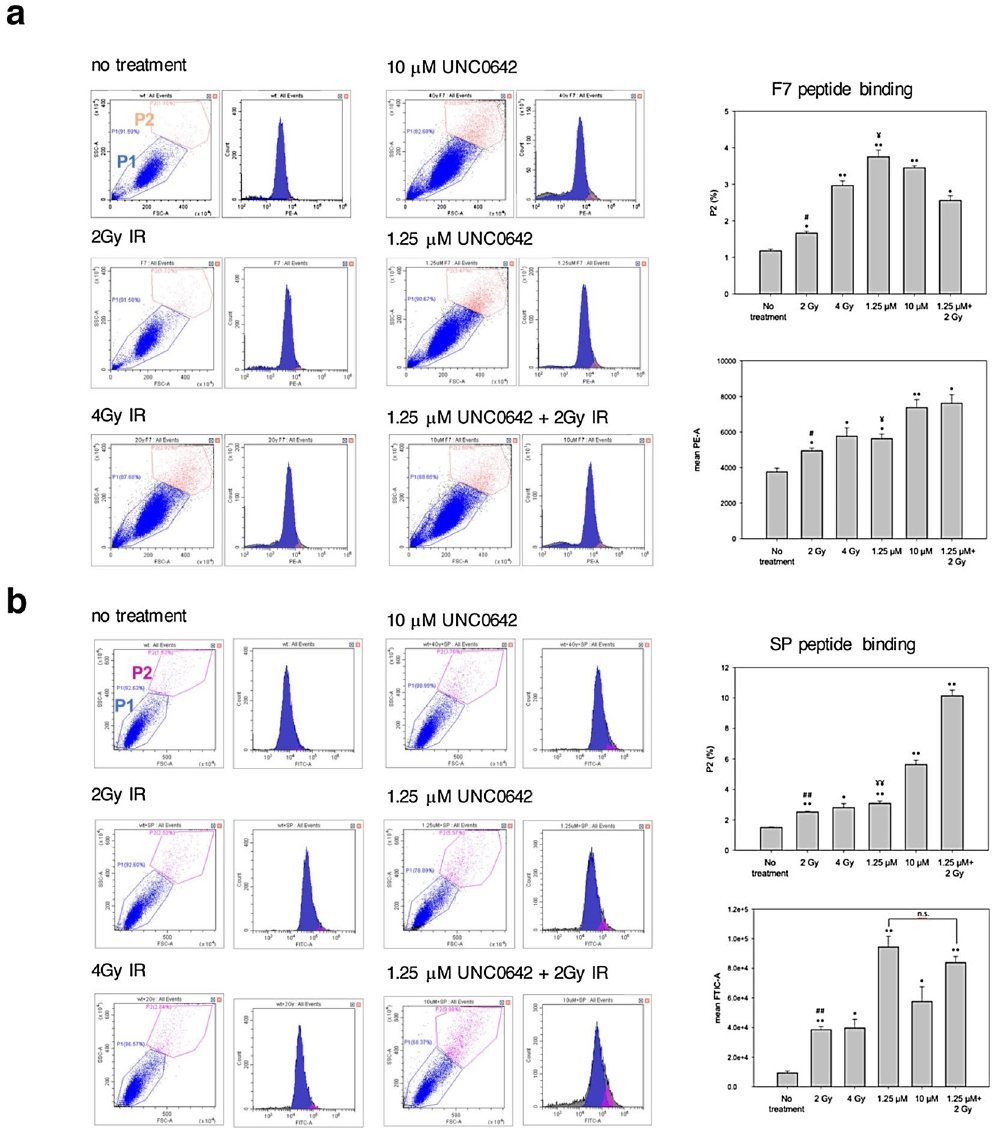
Figure 4. Evaluation of peptide binding activity to EMT derived cells induced by Unc0642/IR. After treatment of Unc0642 or radiation, EMT derived cells were incubated for 24 h in the presence of 50 ng/μl of fluorescein- labeled F7 ( a ) and SP peptide ( b ) at 37 °C respectively. FACS analysis was performed on gated live cells and light scatter parameters were measured using the 488 nm laser. The dot plot represented the particle size (FSC) versus granularity (SSC) of the cell population. The histogram represented the number of cells from P1 and P2 regions displaying a given fluorescence signal. Right graph: the quantitative analysis in the ratio of fluorescein- labeled peptides binding to SAS cells. Symbols (*) denotes significantly different from no treatment group, ( # ) and ( ¥ ) denote significantly different from 1.25 μM + 2 Gy group, respectively. *, # , ¥ p < 0.05, **, ## , ¥¥ p < 0.01, n.s., nonsignificant by Student’s t